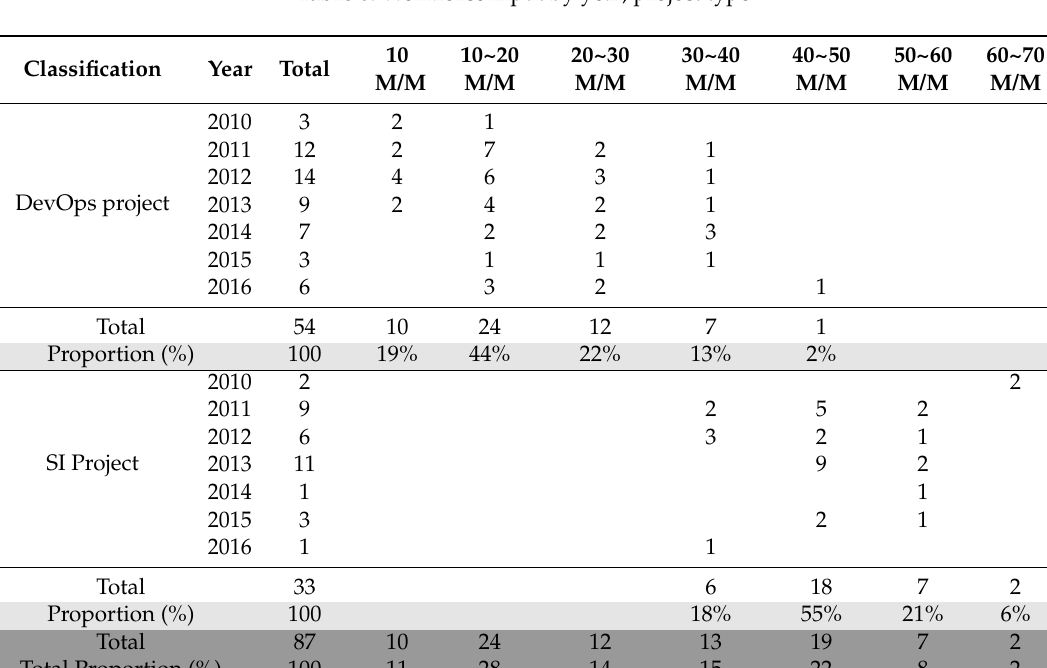
Figure 12. Distribution of differences in expected costs and actual costs. Table 5. The projects distinguished by year, project type, and contract amount. Table 6. Workforce input by year, project